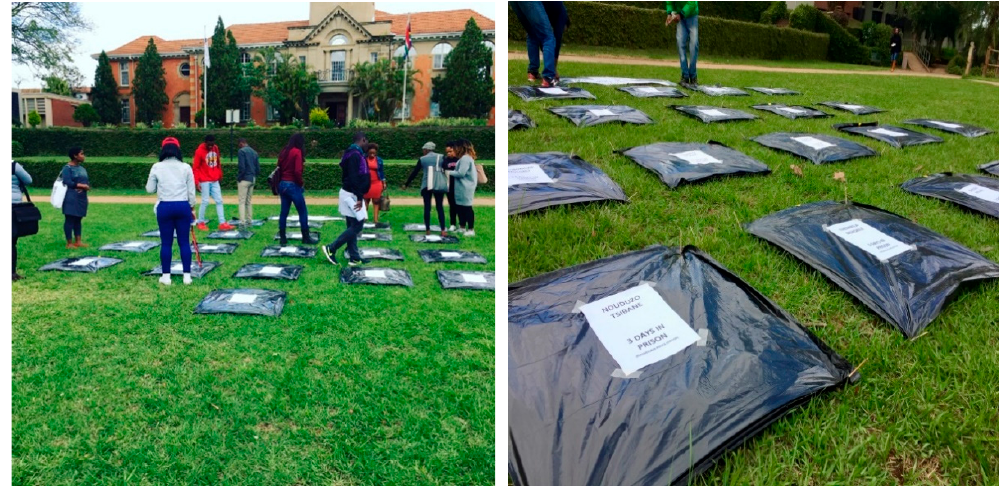
Figure 1. Prisoners’ Memorial.